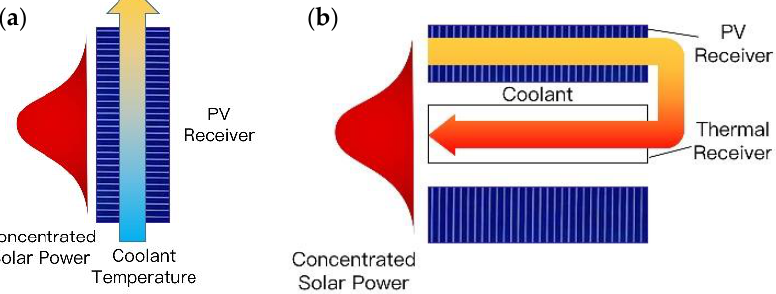
Figure 3. Comparison of CPV/T model coolant, the TFSC. ( a ) Traditional CPV/T model based on waste heat recovery method. ( b ) Novel-type model based on divided heat transfer procedure.